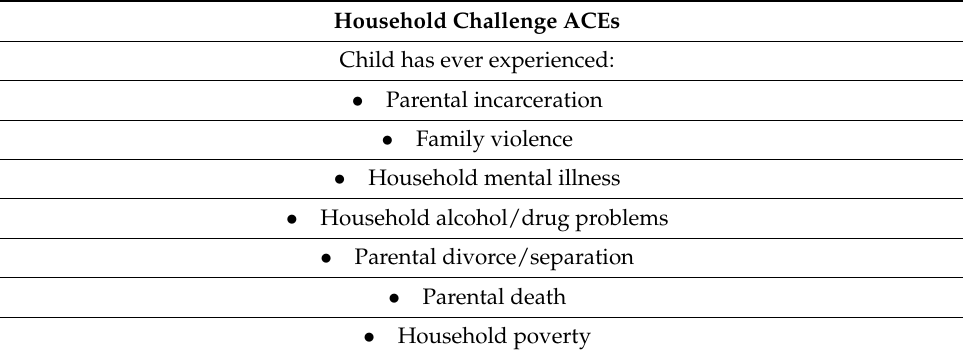
Table 1. Household challenge adverse childhood experiences (ACEs) included in the ACE score. Household Challenge